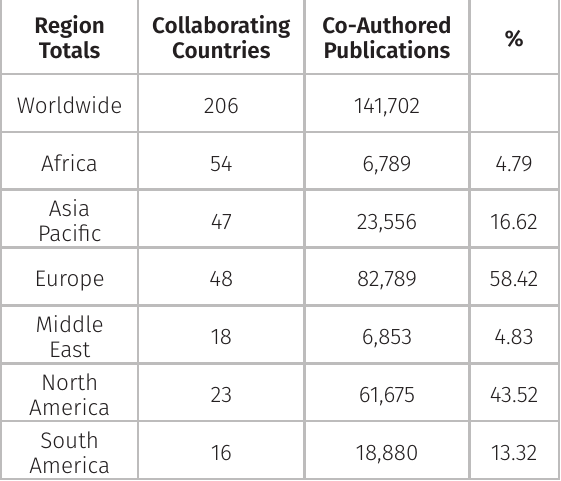
Table I. Publications in co-authorship with non- Brazilian researchers (2013-2019) SciVal.com. Region